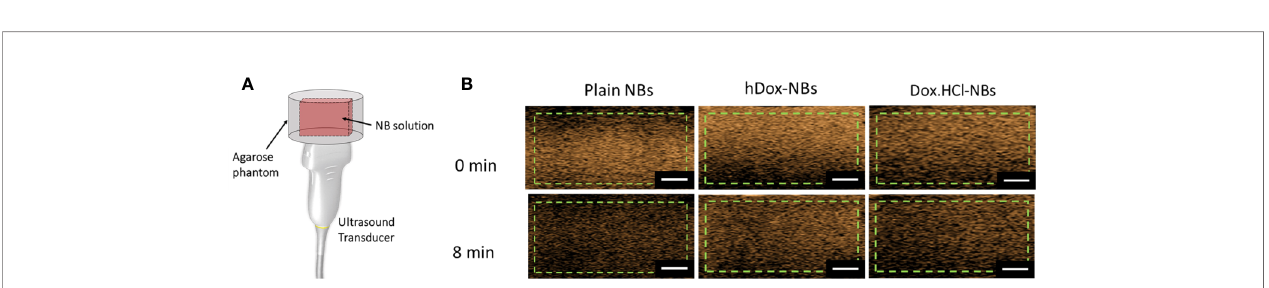
FIGURE 4 | (A) Schematic of the ultrasound transducer and agarose phantom with a thin channel (L × W × H = 22 × 1 × 10 mm 3 ) where is a sample location; As mentioned previously, the phantom design allows the entire bubble sample to be in the acoustic fi eld, as the width of the slot is the same as the element array. This gives a more accurate measure of nanobubble (NB) stability in the acoustic fi eld. (B) Representative ultrasound contrast images for each formulation with the analyzed region of interest (green dashed line). The scale bars are 0.5 cm.